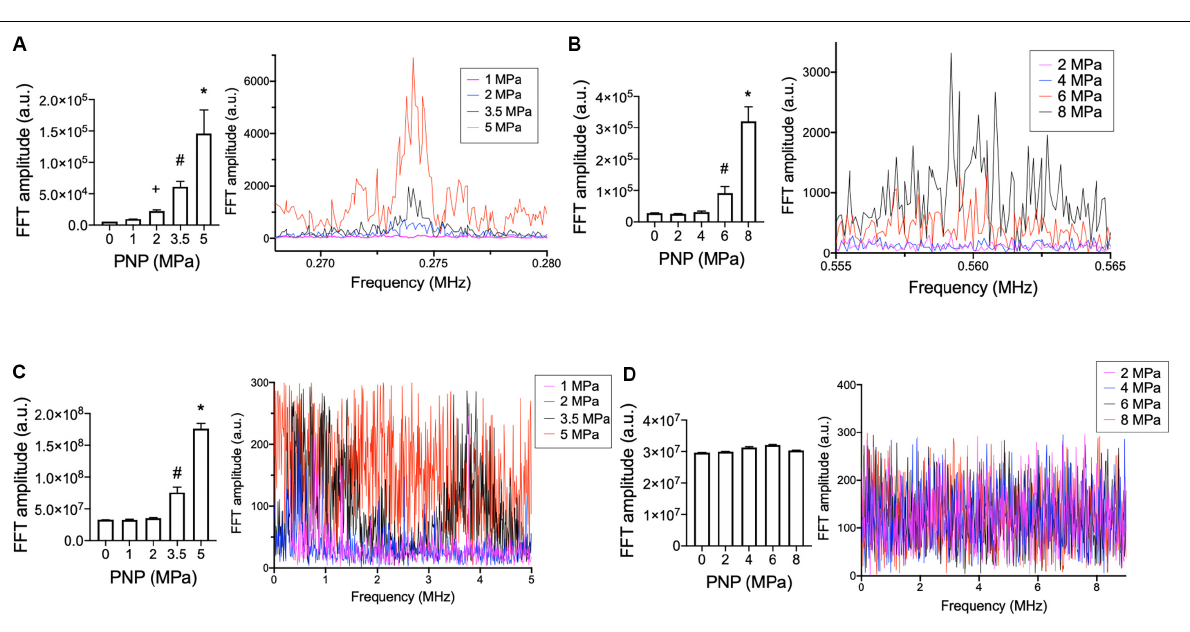
FIGURE 3 | Acoustic emissions from hamstring sonications at 0.548 or 1.125 MHz at different PNP. Statistical summaries and representative spectra are shown measuring half-harmonic (A,B) and broadband (C,D) emissions at different PNP for 0.548 MHz (A,C) and 1.125 MHz (B,D) . Graphs represent average values from 100 sonication pulses. Symbols indicate statistical differences ( p < 0.05) from all other values when compared by